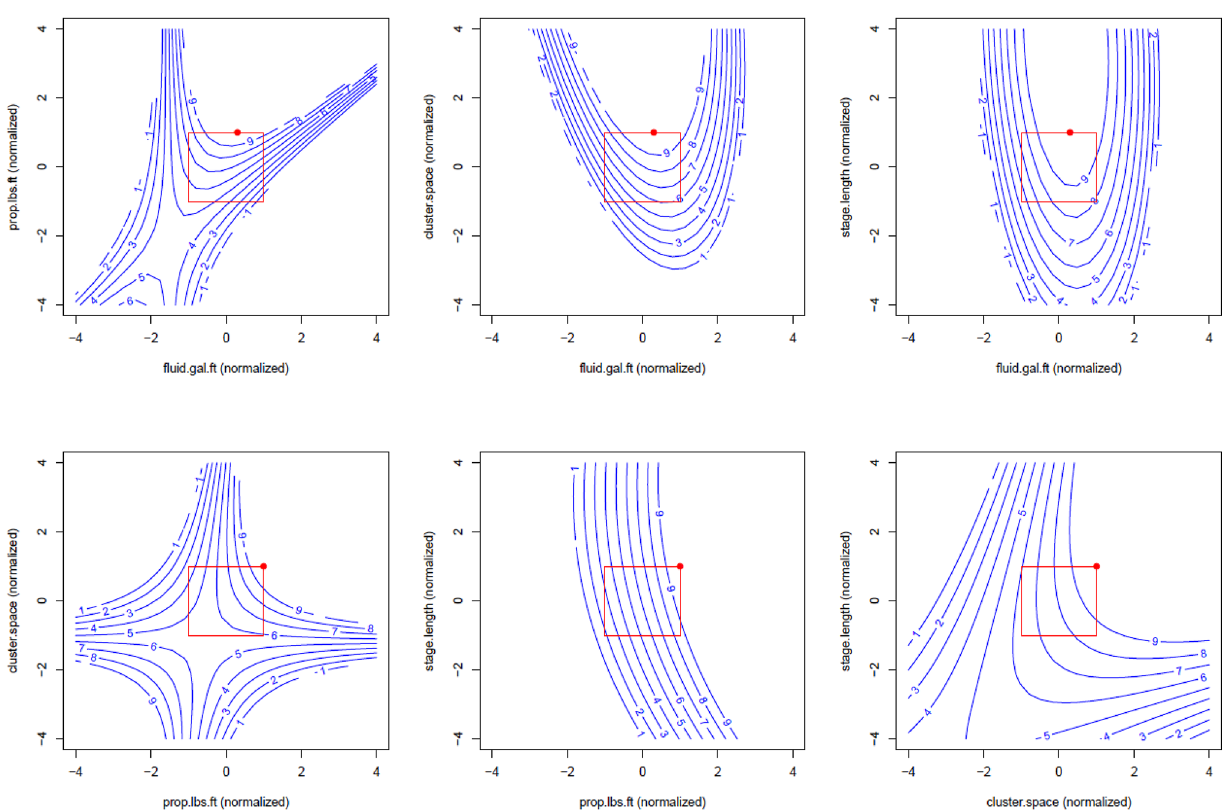
Fig. 6 Contour plots of normalized log (IP 180) versus 2D-slice of various input